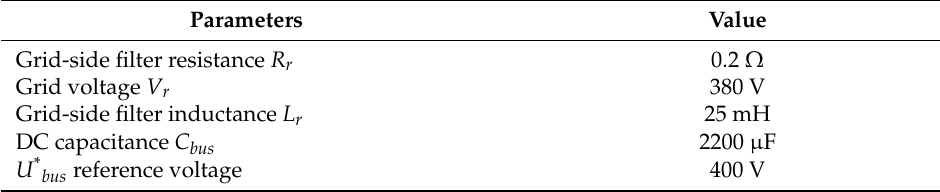
Table 4. Parameters of power grid.